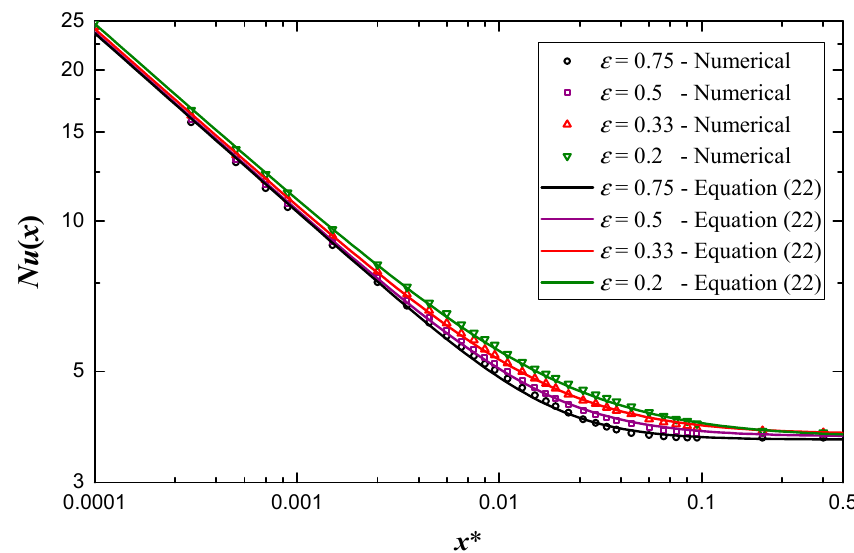
Figure 7. Comparison of Equation (22) and a portion of numerical results at Re = 1000.